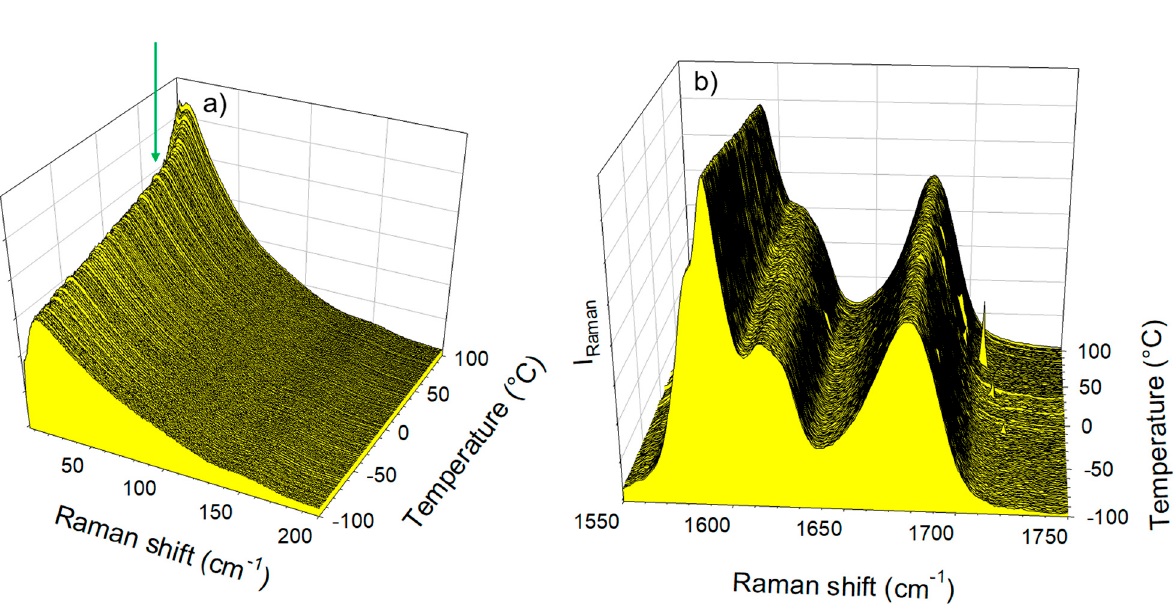
Figure 8 . Temperature dependence of the quasielastic intensity ( a ) determined for IMC–TLE and IMC–ARG blends compared with that of the glassy state of the IMC and ( b ) determined in the amor- phous ARG compared with that of the crystalline ARG .